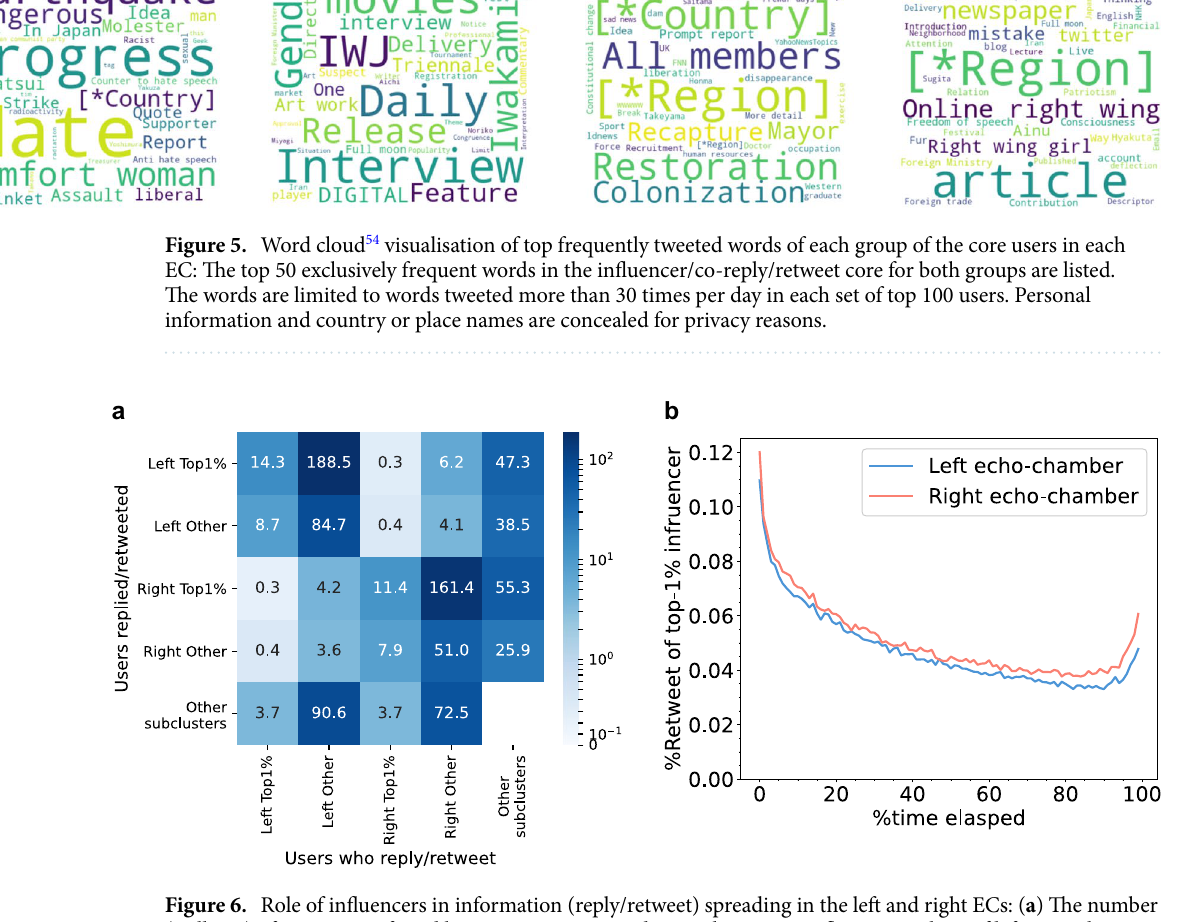
Figure 6. Role of influencers in information (reply/retweet) spreading in the left and right ECs: ( a ) The number (millions) of tweets transferred between groups according to the top 1% influencers/others of left EC/right EC and other subclusters. ( b ) Timeline of the average participation ratio of the top 1% influencers in the highly replied/retweeted tweets (retweeted/replied more than 1000 times) in each EC. The tweets arranged in the time series are divided into 100 equal groups, and the ratio is calculated for each period. We ignore the few tweets one week after the first